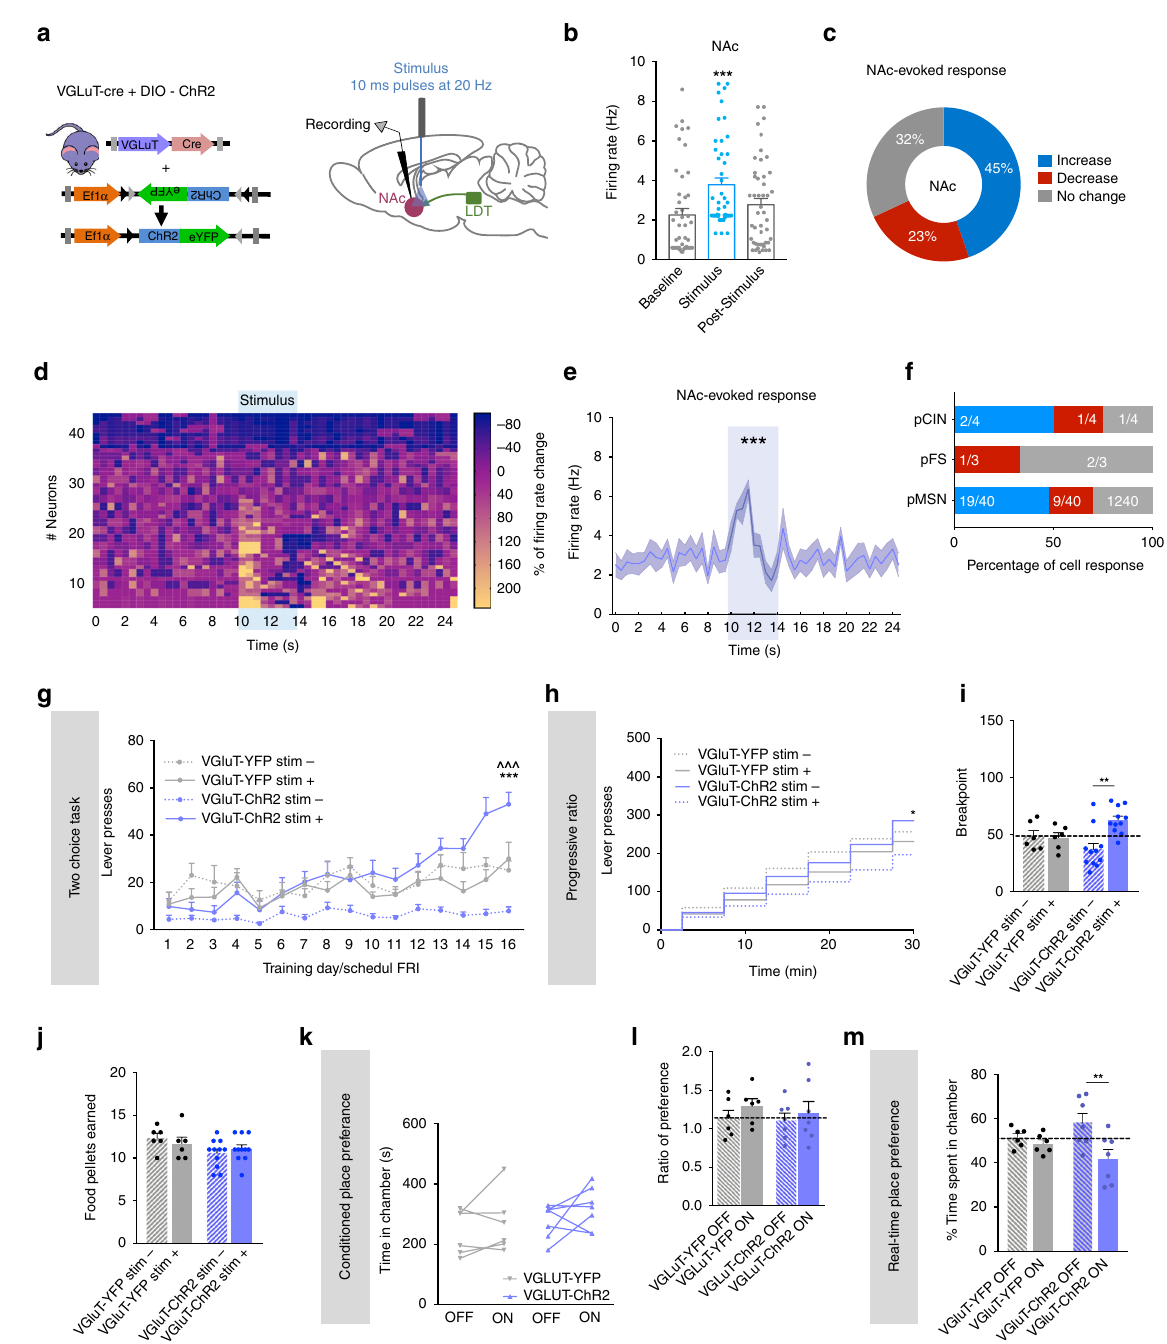
Fig. 5 Optogenetic activation of LDT-NAc glutamatergic inputs during reward-related behaviors. a Strategy used for optogenetic manipulation of LDT glutamatergic terminals in the NAc. DIO-ChR2 was injected in the LDT of VGluT-cre mice, and optical stimulation was performed in the terminals in the NAc. b Stimulation of glutamatergic terminals increase NAc net fi ring rate ( n = 4 animals; 42 cells; RM 1way ANOVA). c 45% of NAc cells show an increase in the fi ring rate during stimulation, 32% present no change and 23% decrease activity. d Heatmap representation of percentages of cell responses in the NAc upon stimulation of glutamatergic terminals. e Average fi ring rate of NAc neurons showing an increase in activity from the baseline during stimulation (KS test). f Percentage of responses of each NAc cell type to glutamatergic LDT terminal activation. g Time-course representation of the responses in the two-choice task of VGluT-ChR2 ( n = 11) and VGluT-YFP ( n = 6) mice on stim + and stim- lever. VGluT-ChR2 animals prefer the stim + over stim- lever; no preference is observed in VGluT-YFP animals. h Cumulative presses performed during the progressive ratio task, showing increased presses in stim + lever in VGluT-ChR2 animals. i Breakpoint is increased on VGluT-ChR2 animals for the stim + in comparison to stim- lever, though not statistically different from control group. j Number of pellets consumed during progressive ratio sessions. k Total time spent in the ON and OFF chambers in the CPP test, showing no preference. l Ratio of preference between ON and OFF chambers. m Percentage of time spent in each side of the RTPP test, showing decreased time spent in the ON chamber in VGlut-ChR2 animals ( n = 7, four animals lost canula) but not in VGlut-YFP group. Values are shown as mean ± s.e.m. *refers to difference between VGluT-ChR2 stim + and stim- lever, RM 2way ANOVA; ^refers to difference between VGluT-ChR2 stim + and VGluT-YFP stim + lever, RM 2way ANOVA. * p < 0.05; ** p < 0.01; *** p <